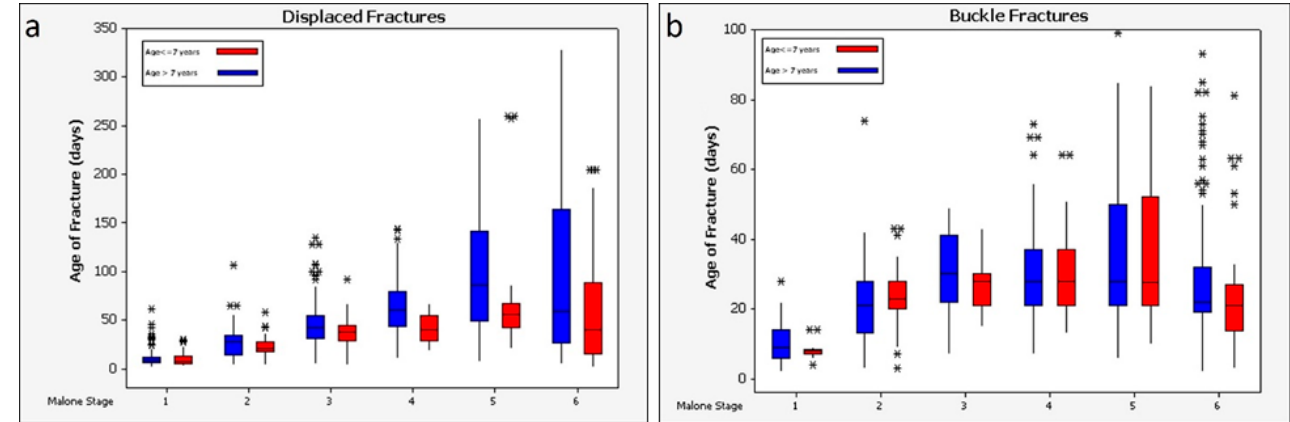
Figure 5. Descriptive plots of the fracture datasets, by Malone stage, and grouped by patients age 7 and younger (red) and those older than 7 (blue). (Note: recorded fracture ages greater than 350 days are truncated for clarity). ( a ) displaced, ( b ) buckle fractures.